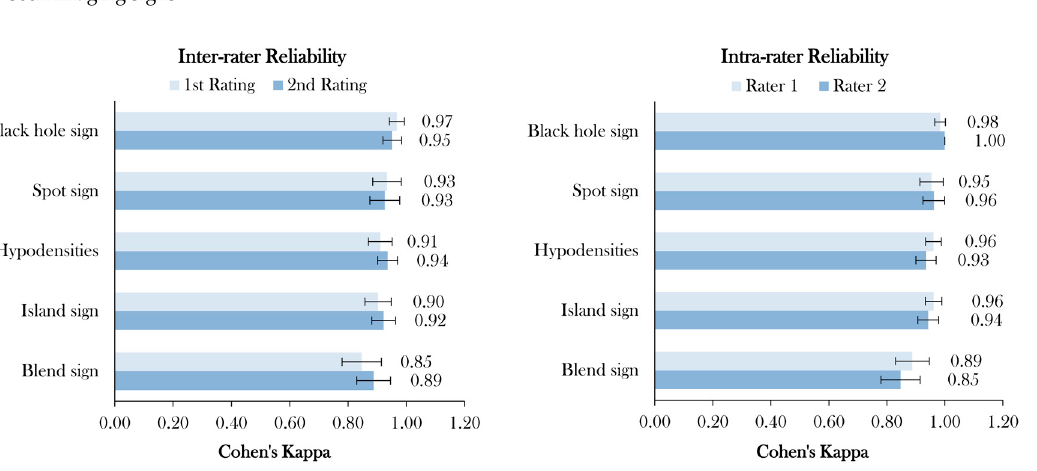
Table 5. Intrarater agreement of two readings stratified across two raters.